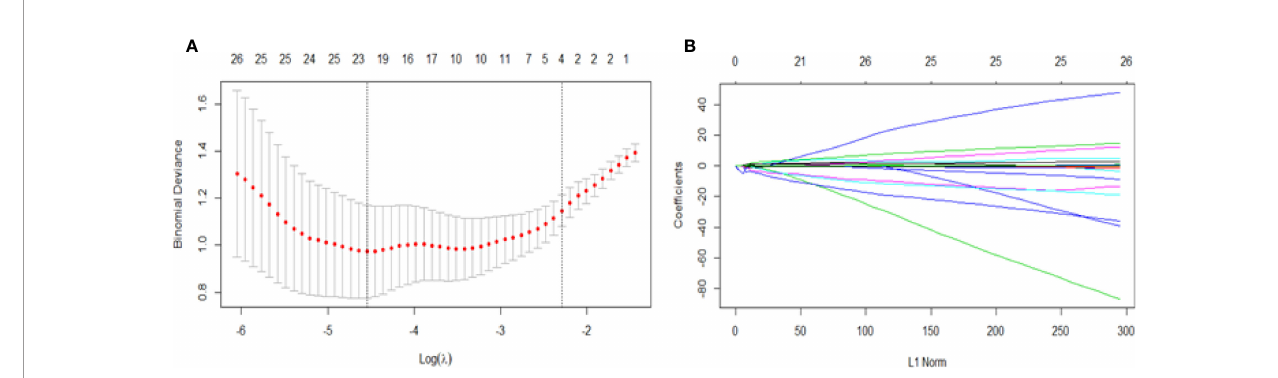
FIGURE 3 | Feature selection for the LASSO algorithm. (A) The fi gure shows binomial deviance (y-axis) plotted against log ( l ) (x-axis). The left dotted vertical line is drawn at the optimal value of l (min l value = 0.0106, log ( l ) = -4.5468), where the model provides the best fi t of the data, corresponding to the number of selected features (23). The right vertical dotted line represents the value of l that yields the best minimum deviation value (minimum l standard deviation value = 0.1011, log ( l ) = - 2.2912). (B) LASSO coef fi cient pro fi les for all features, which shows that the coef fi cients of 271 texture features changes with the fi nal selections of different numbers of features.